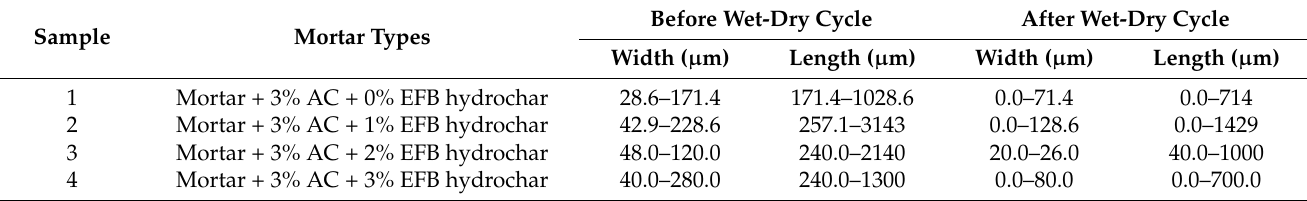
Table 13. The crack dimensions in the mortar with the addition of OPEFB hydrochar fibre, before and after the wet-dry cycle treatment.